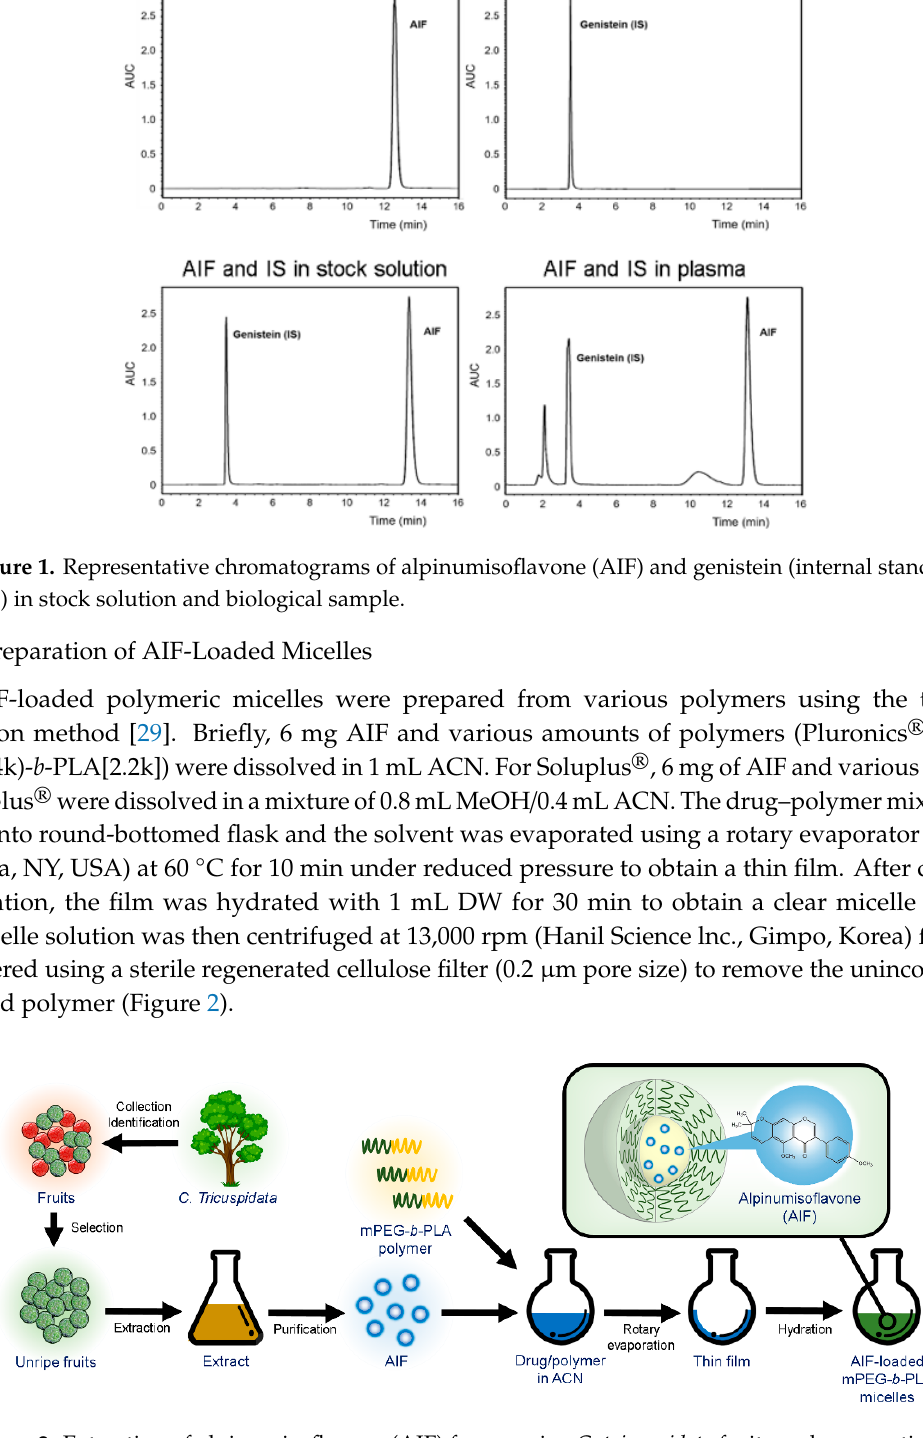
Figure 2. Extraction of alpinumisoflavone (AIF) from unripe C. tricuspidata fruits and preparation of AIF-loaded polymeric micelles using thin-film hydration method.